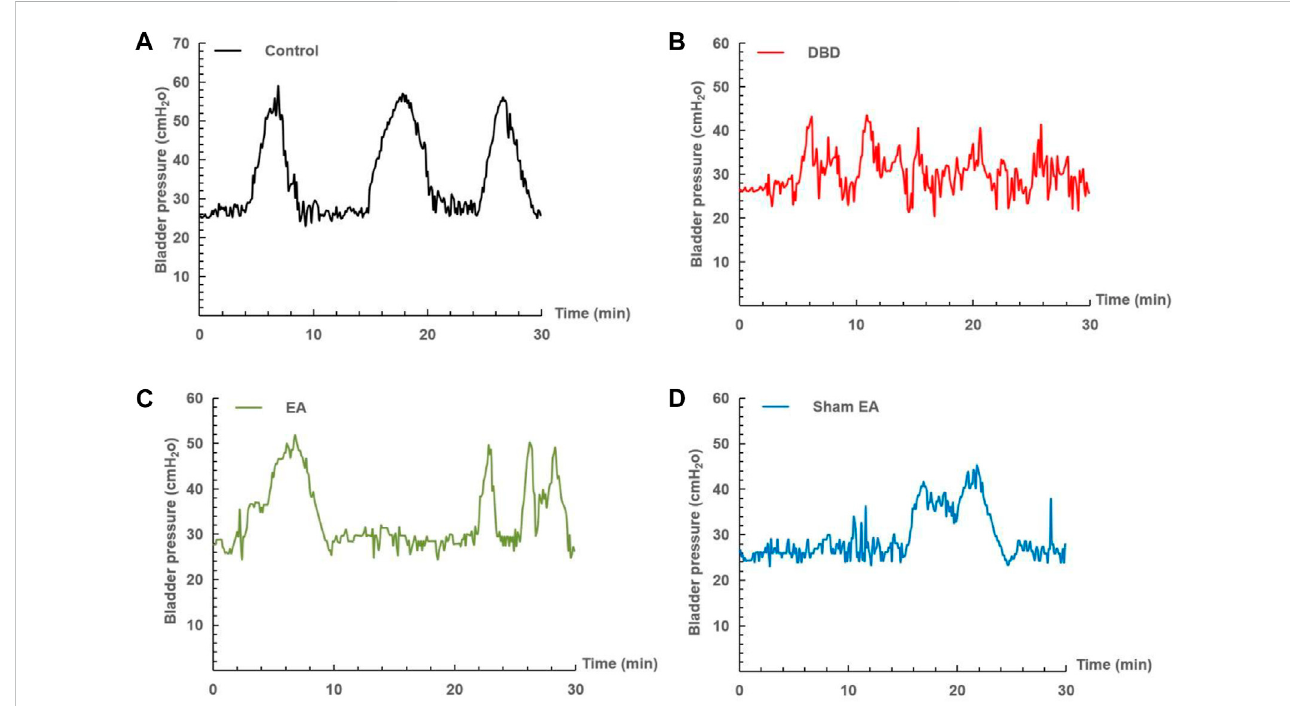
FIGURE 3 Representative cystometry records of each group. Assessment of voiding function with cystometry. EA-treated DBD model rats tended to have normal voidingpatterns. (A) A normalvoidingpatternwasnotedintheControlgroup. (B) AnoveractivebladderpatternwasnotedintheDBDgroup. (C) Theunstable spontaneous contractile bladder pattern was noted in the EA group. (D) An abnormal voiding bladder pattern was noted in the Sham EA